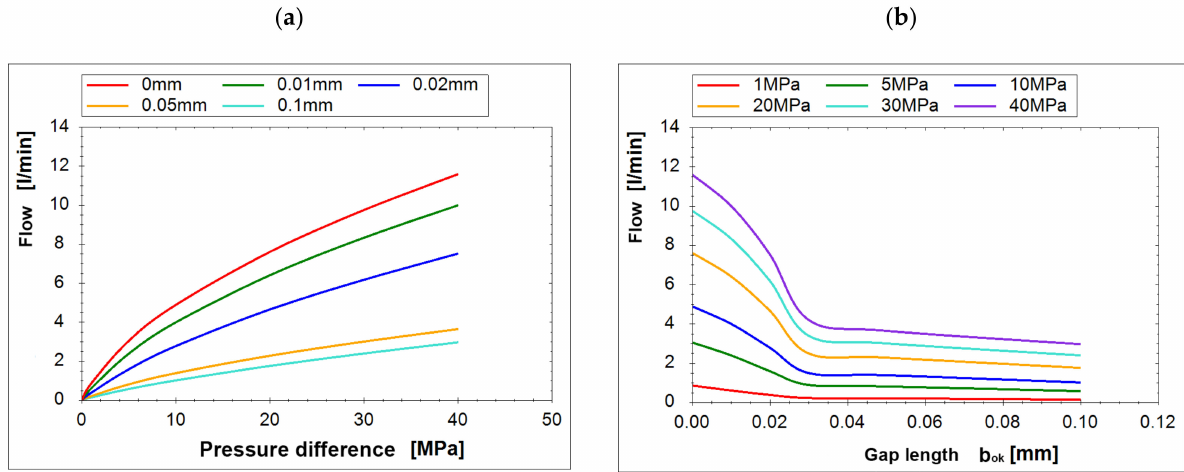
Figure 18. Influence of the pressure difference between the inlet and outlet of the gap and the gap length on the leakage flow: ( a ) characteristic of the flow as a function of pressure difference ∆ p for different gap lengths b ok ; ( b ) characteristic of the flow as a function of gap length b ok for different pressure differences ∆